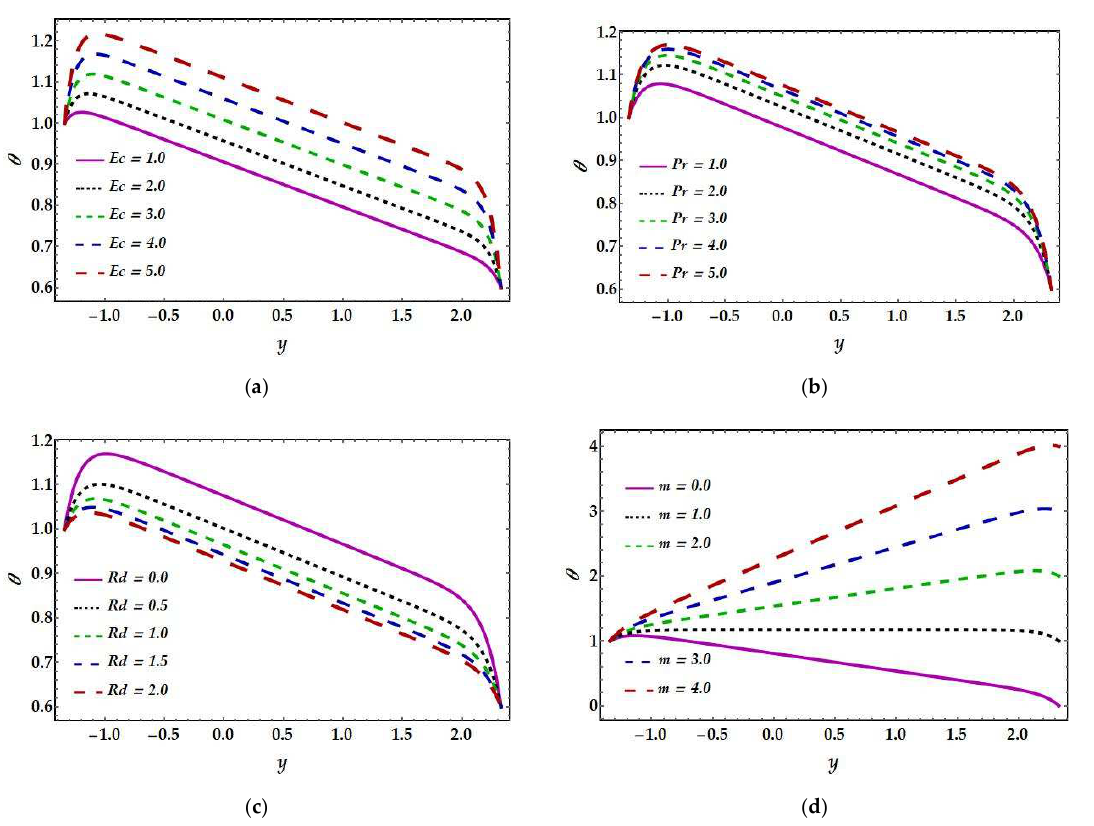
Figure 7. Effects of different physical parameters on temperature profile θ . 4.7. Trapping Phenomena